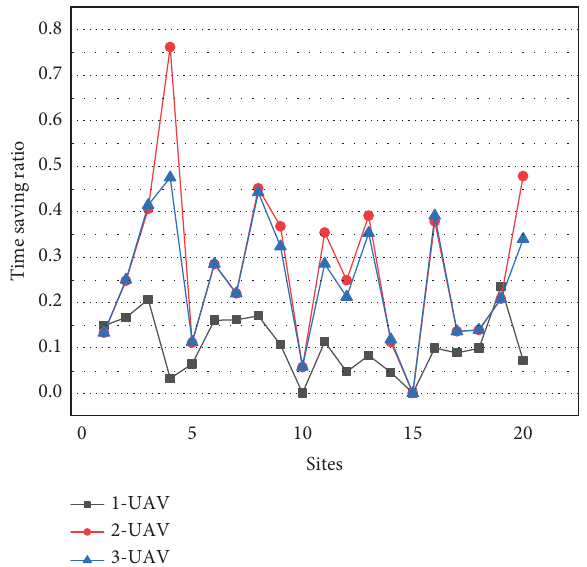
Figure 8: Te ratio of time saved by drones to total